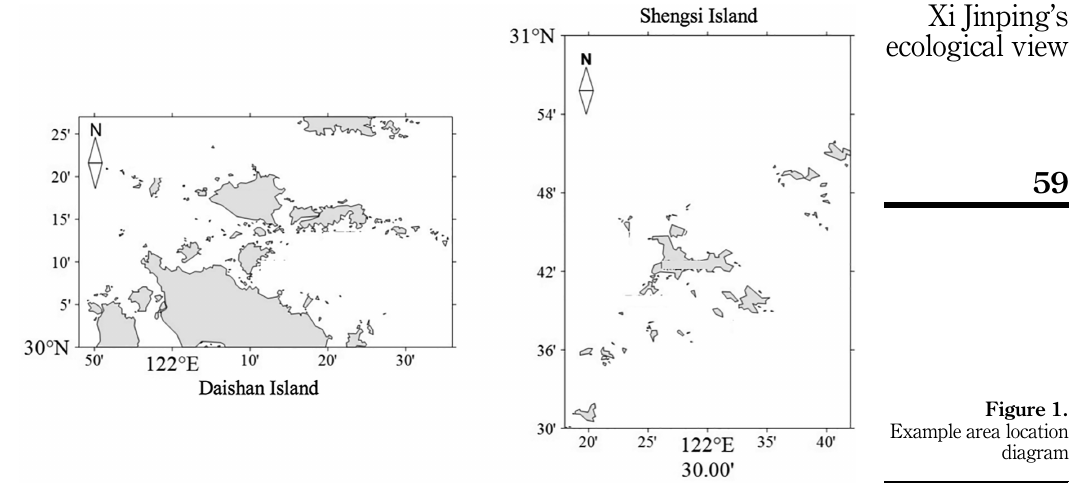
Figure 1. Example area location